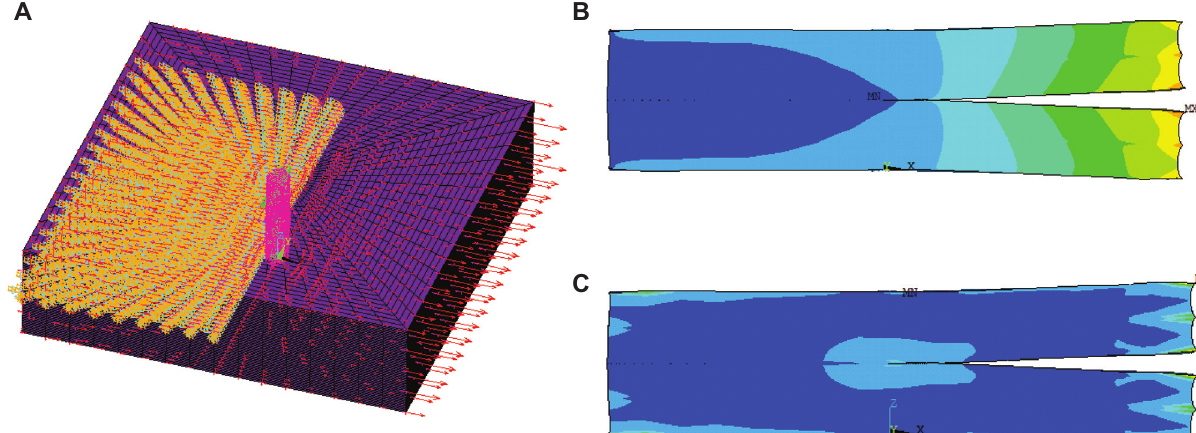
Figure 2 (A) FE meshes of RVE (iso view), (B) displacement, and (C) stress contours of RVE.